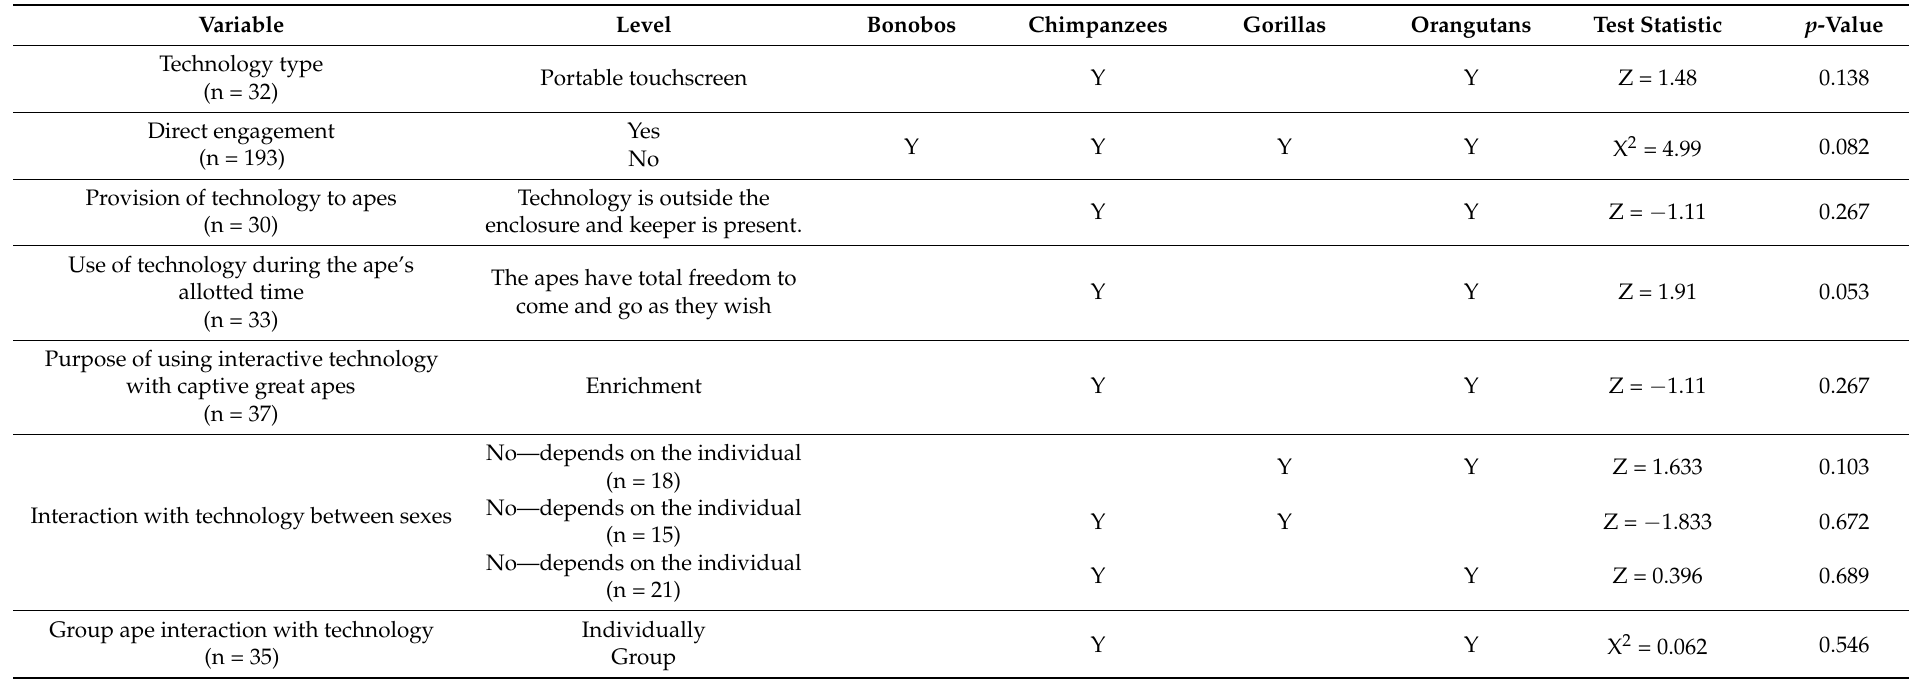
Table 4. Output from statistical analyses. The ‘n’ indicates the total number of responses irrespective of ape group for the respective variable. The ‘Y’ indicates the ape groups that were compared for the corresponding test